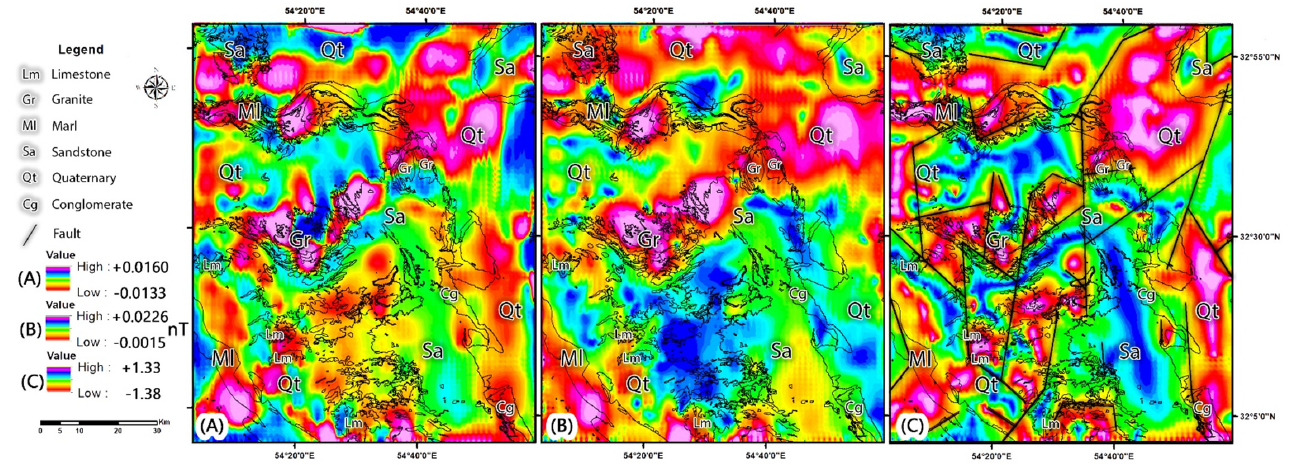
Figure 8. ( A ) First vertical derivative map; ( B ) Analytical signal map; ( C ) TDX map for the study area.